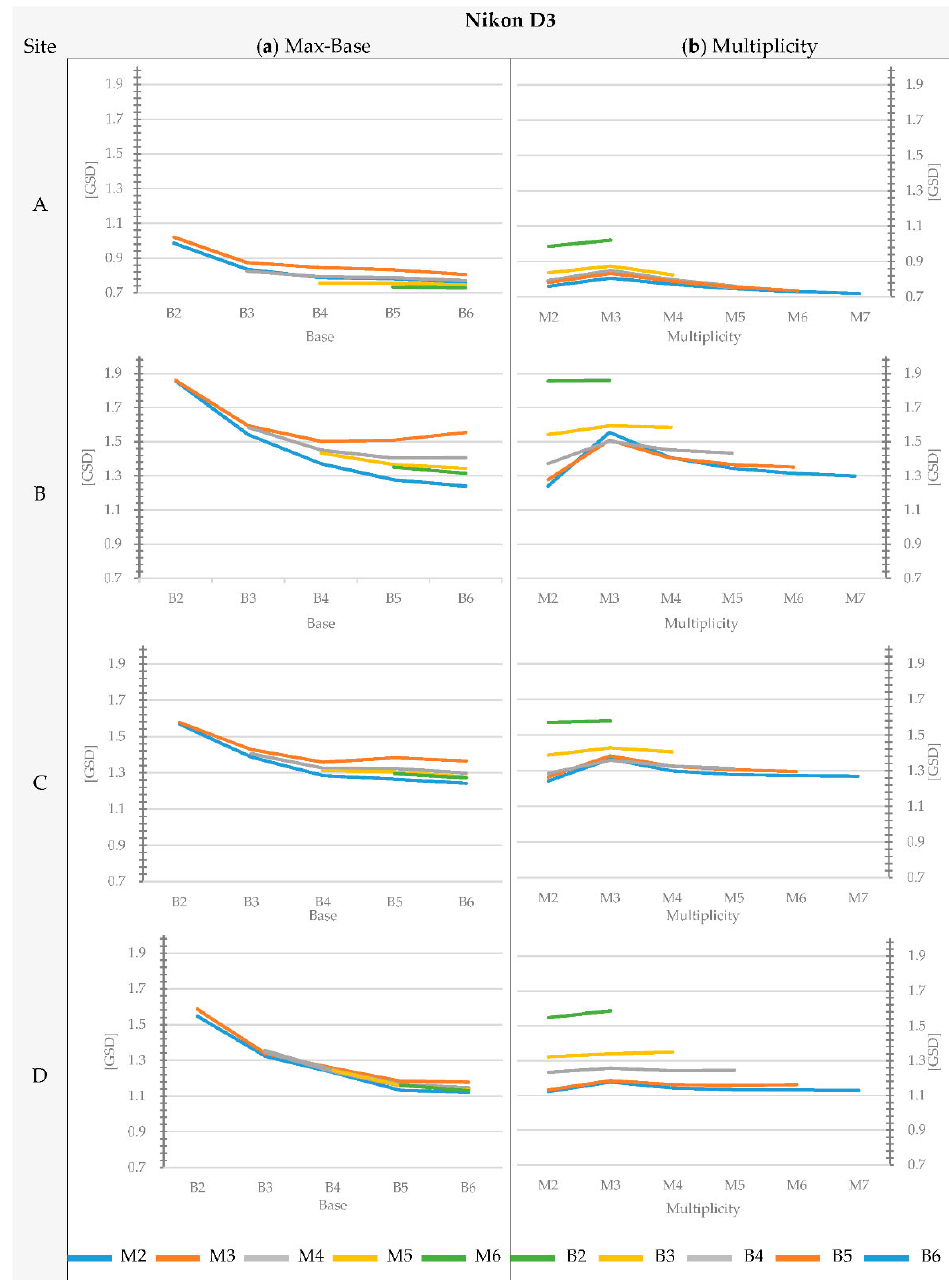
Figure 7. Graphs showing the standard deviation of the elevation disparity between DEMs and the reference model for Sites A, B, C and D, using Nikon D3, as a function of ( a ) max ‐ base variability and ( b ) multiplicity. (Value of standard deviation for combinations B1 ‐ M2: Site A = 1.70, Site B = 2.87, Site C = 2.27, Site D = 2.32 times the GSD) .